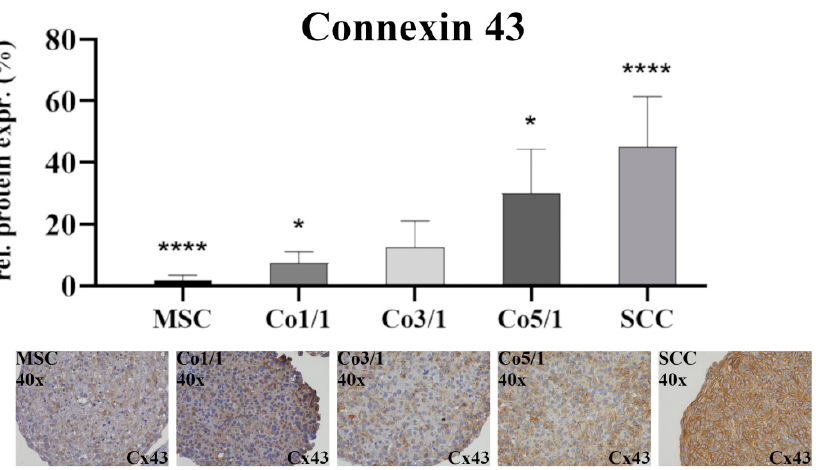
Figure 2. Immunohistochemical staining of connexin 43 in MSCs, Co1/1, Co3/1, Co5/1, and SCCs; magnification 40 × . **** = p ≤ 0.0001, * = p ≤